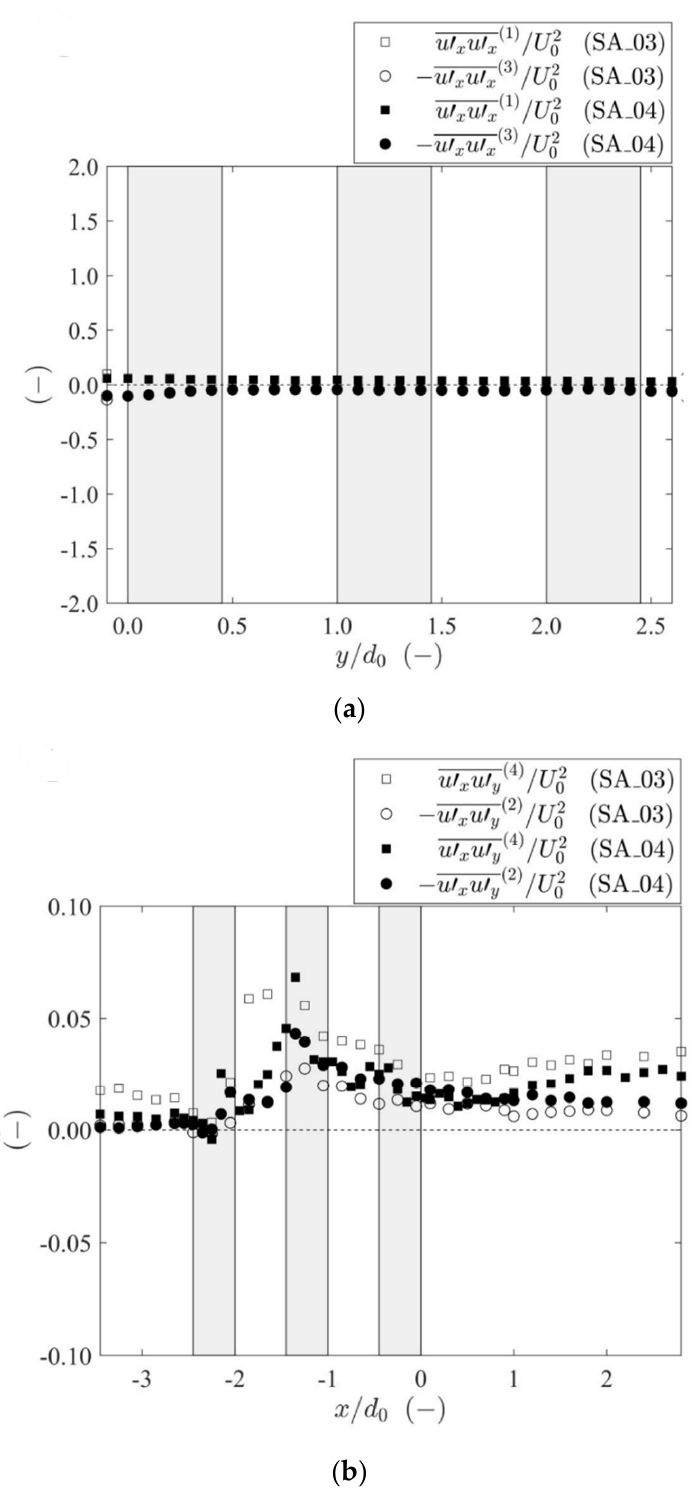
Figure 6. Distribution of turbulent transport on ( a ) S 1 , S 3 and ( b ) S 2 , S 4 .